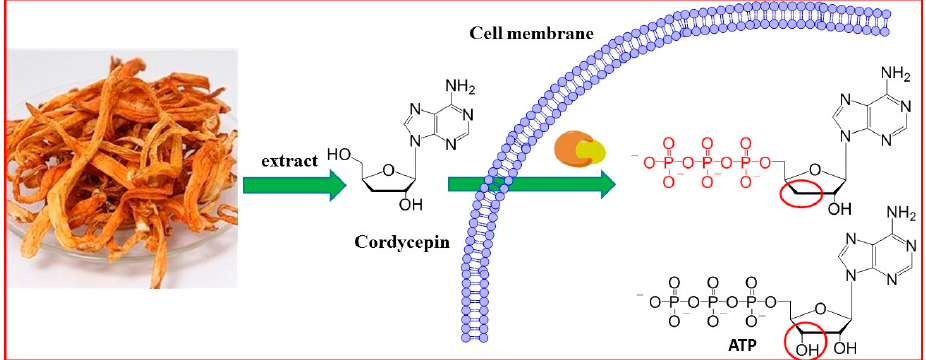
Figure 1. Chemical structure of cordycepin and ATP.